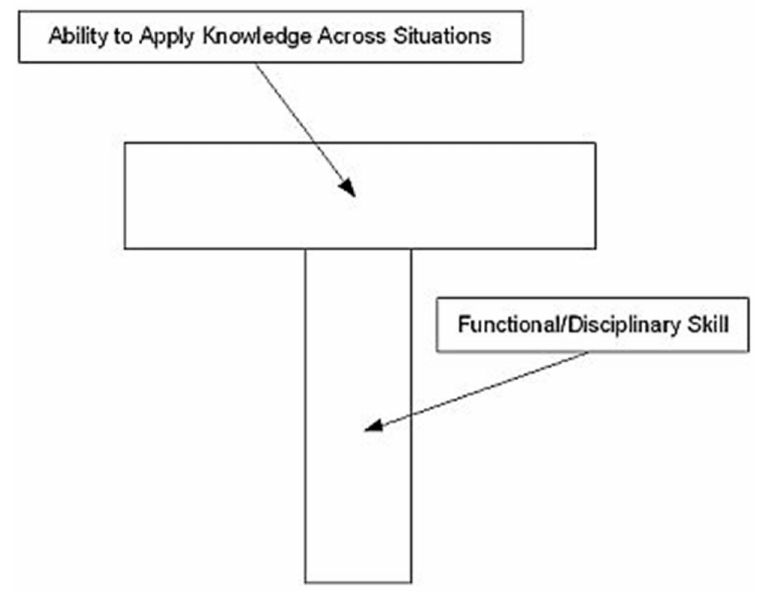
Figure 11. T-shaped skills of professionals